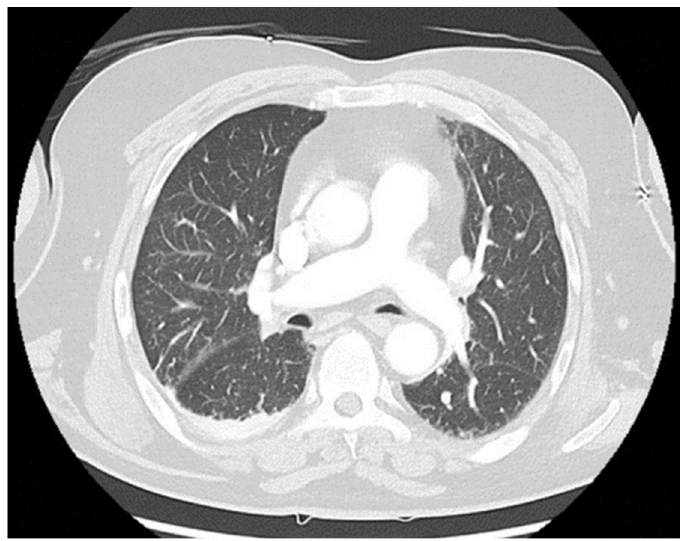
Figure 2. Representative CT scan slice of the chest imaging study.